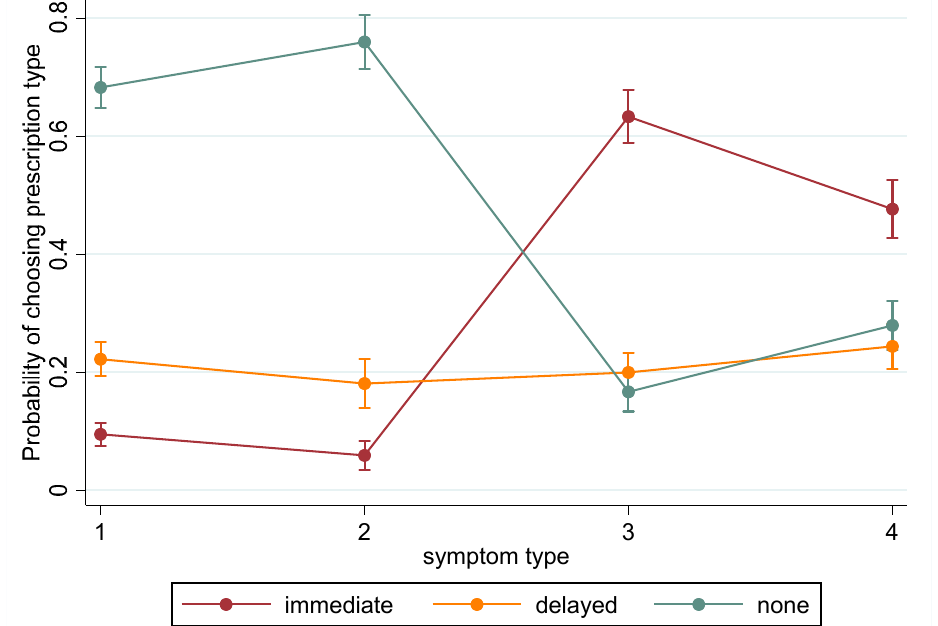
Figure 4. Probability of choosing immediate, delayed or no prescription, for each symptom type. Symptom descriptions: 1 minor throat—sore throat and swollen glands; 2 minor chest—chesty cough and runny nose; 3 serious throat—sore throat, swollen glands and fever; 4 serious chest—chesty cough, fever and pain on breathing. Bars indicate 95% confidence intervals.